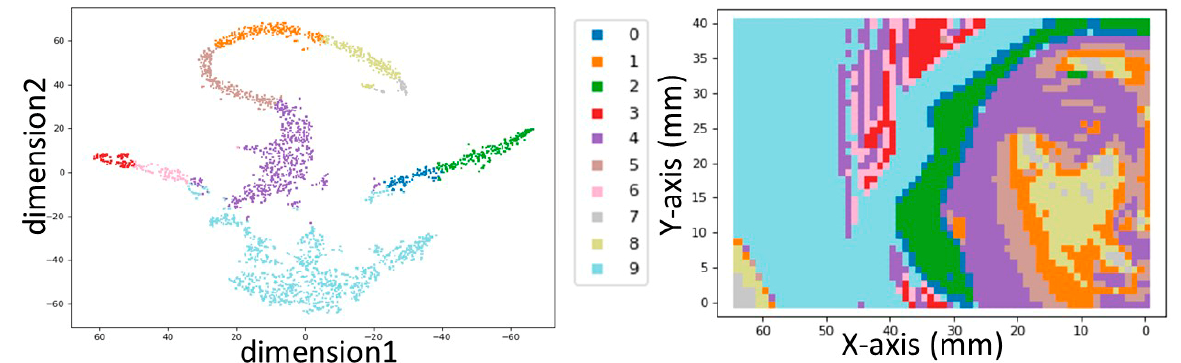
Figure 5. Left : Two − dimensional scatter plot of the 2665 measured points (pixels) distributed in 10 clusters, after dimensionality reduction. Right : Clusters distribution in the real space of the icon.